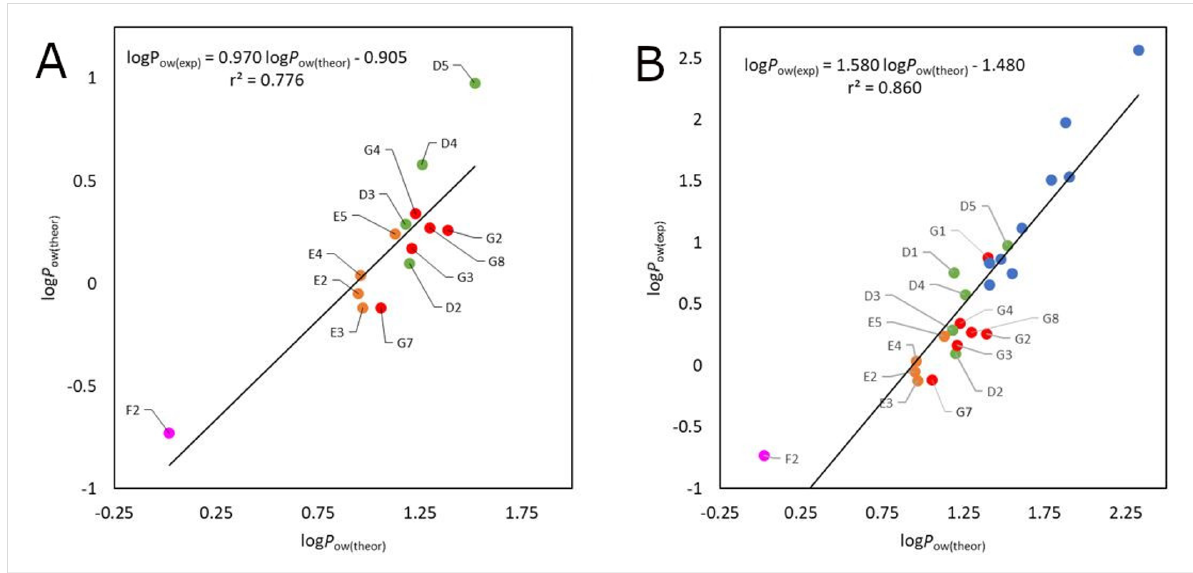
Figure 10: Correlation of the DFT-calculated lipophilicities with the experimental values. A) fluorinated series D , E , F , G2 – 4 , G7 , G8 , B) Compilation with other fluorohydrins (taken from reference [28]).